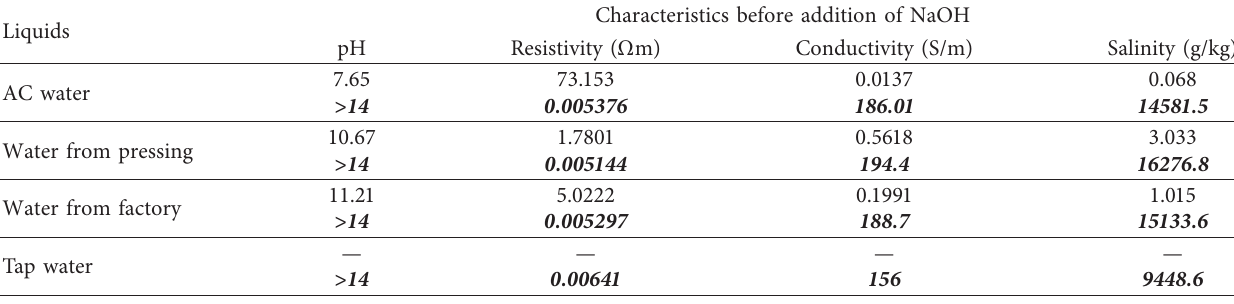
Table 4: Characteristics of the samples at 25 °